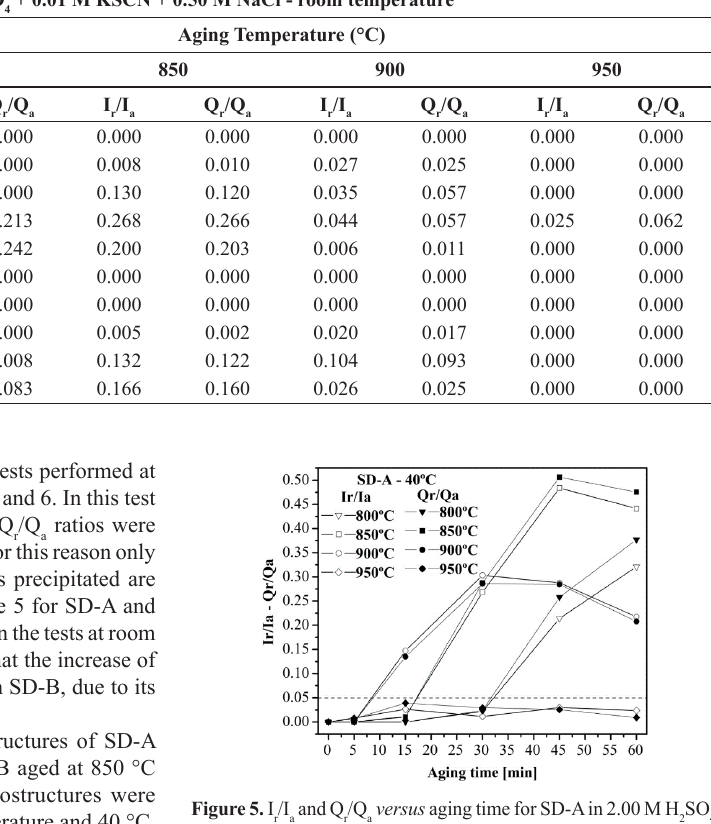
/I and Q /Q versus aging time for SD-A in 2.00 M H r a r a